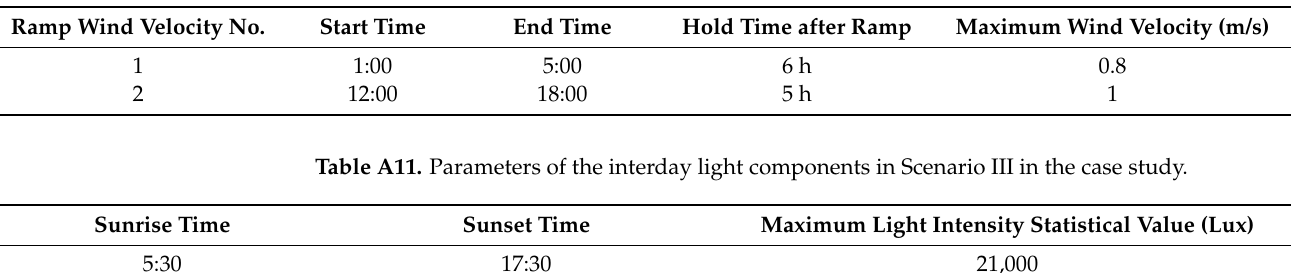
Table A10. Parameters of the ramp wind velocity in Scenario III in the case study.